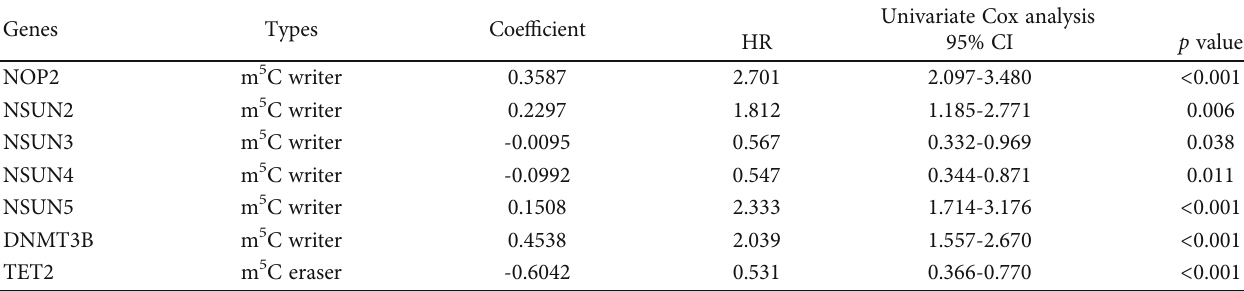
Table 3: List of m 5 C RNA methylation-related genes for constructing prognostic risk score.